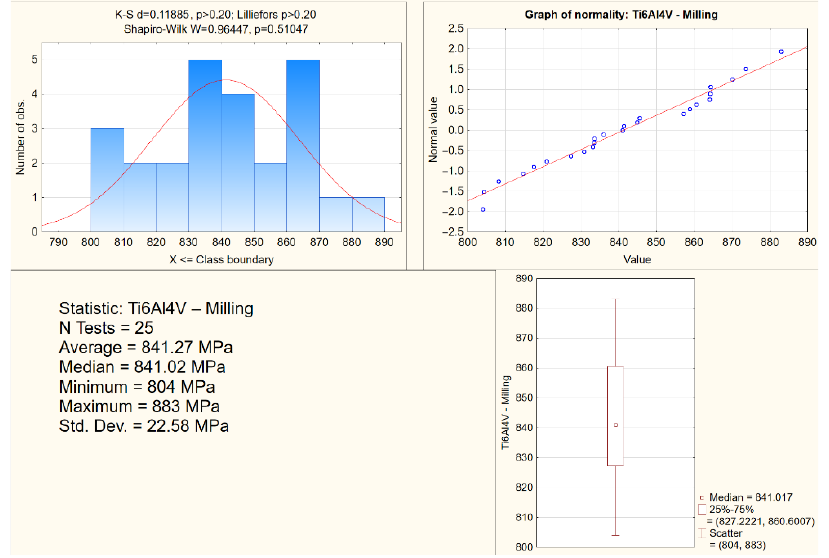
Figure 9. An exemplary analysis of the normality of the offset yield stress distribution in compression tests for Ti6Al4V from milling.